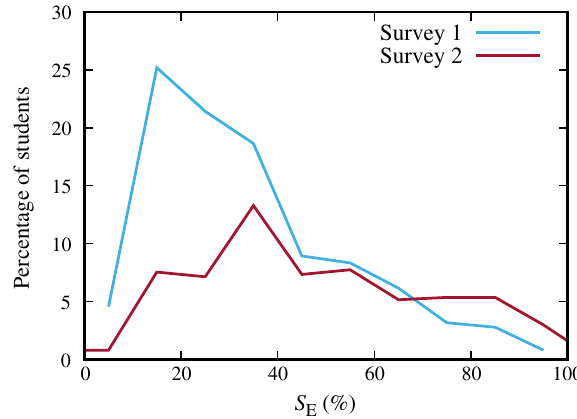
FIG. 1. Distribution of percentage epistemic scores ( S students.